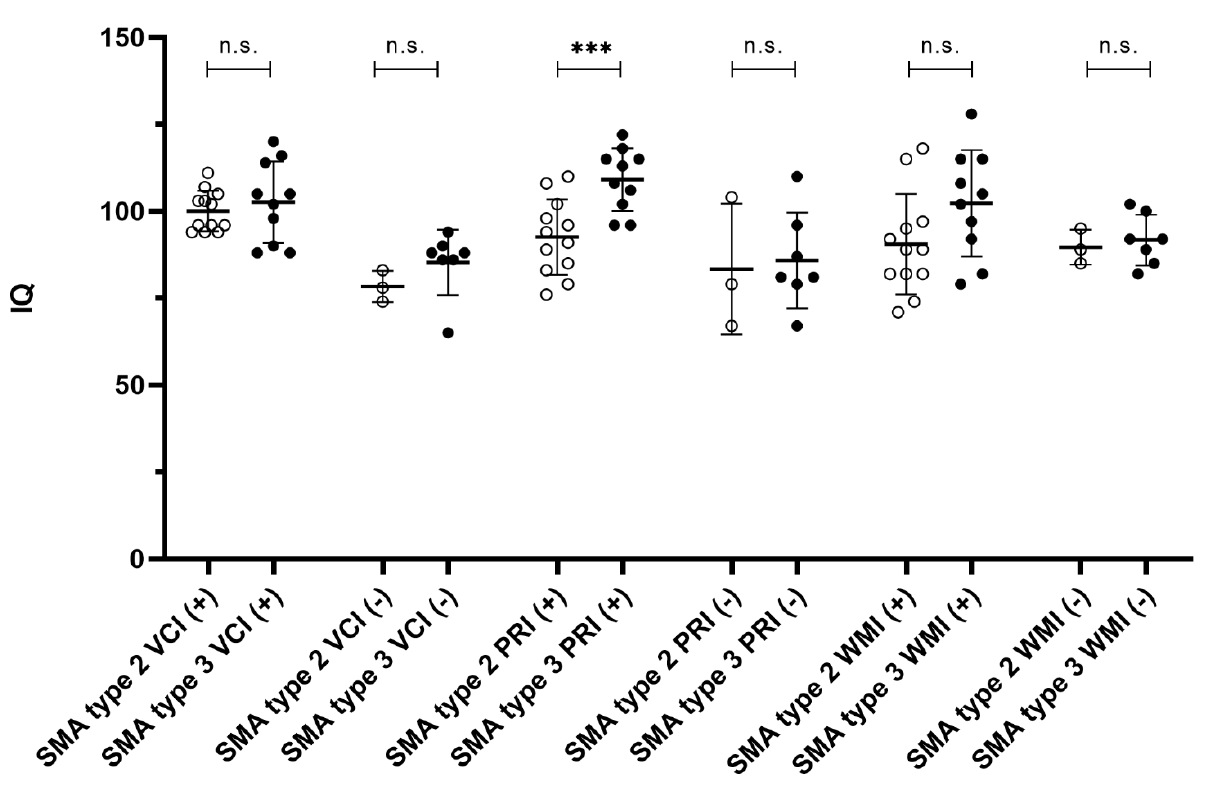
Figure 3. Intelligence quotient (IQ) and educational level. Intelligence quotient of the IQ subgroups (VCI, PRI, WMI) of patients with SMA type 2 (unfilled circles) and 3 (filled circles) subdivided into achieved university entrance qualification (+) and unachieved university entrance qualification ( − ). The IQ of the PMI in SMA type 2 patients with university entrance qualification is significantly reduced (***) compared to SMAP type 3 patients with university entrance qualification. The IQ of the other comparison groups did not differ (n.s.).